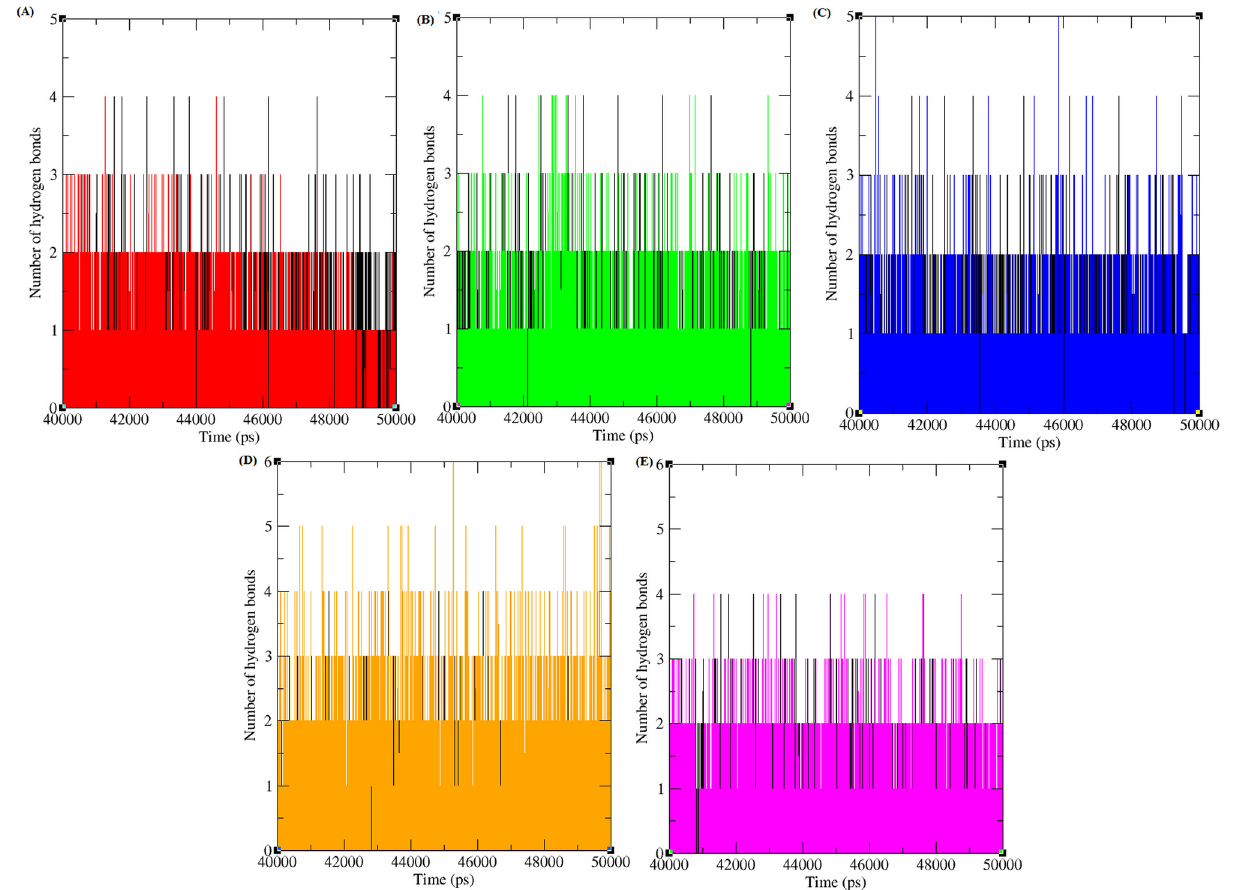
Fig 5. Total number of hydrogen bond formed between CDK4 and different inhibitors in native and mutant state. Black, Red, Green, Blue, Orange and Pink lines indicate the hydrogen bonds formed between CDK4-flavopiridol, R24C-5_7_DIHYDROXY_ 2_ (3_4_5_TRI HYDRO